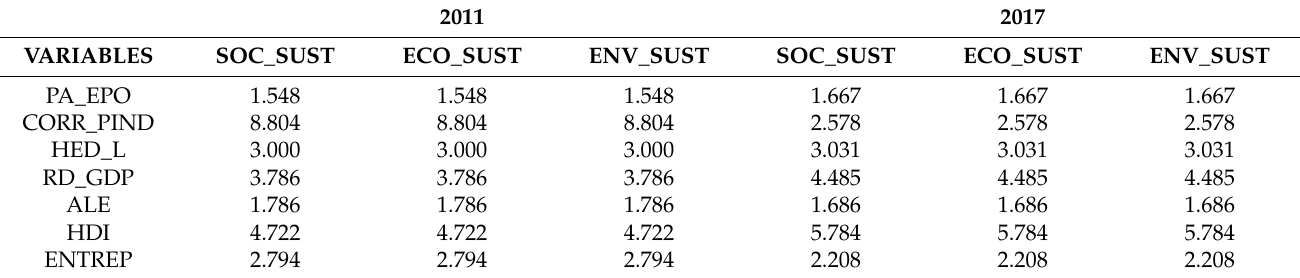
Table 5. Variance inflation